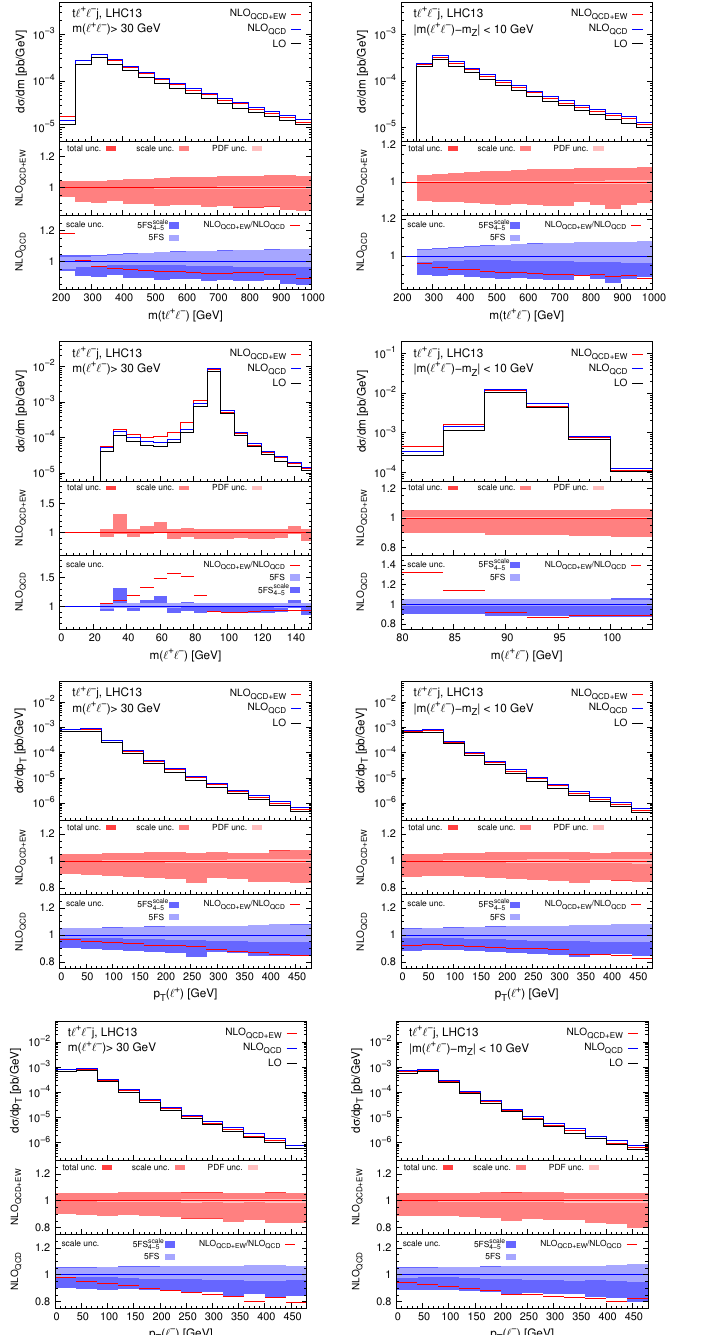
Figure 8 . Further plots as in (cid:12)gures 6 and 7 for t‘ + ‘ (cid:0) j lepton-based observables. The \inclusive" case is displayed on the left while the Z -peak one on the right. the NLO scale-uncertainty band, even in the 5FS scale QCD lepton p distributions. These exhibit the typical behaviour of EW corrections, with large T (reaching 20%) negative corrections in the tails of the distributions. Using the 5FS scale